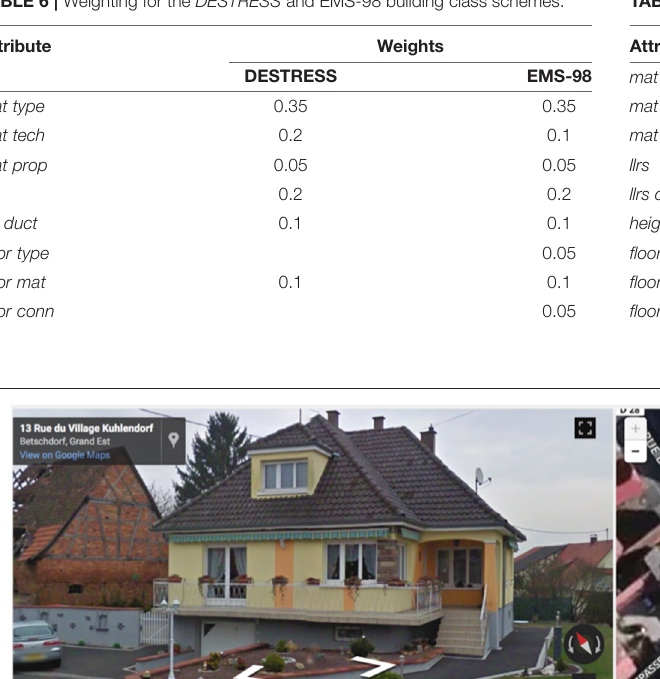
TABLE 6 | Weighting for the DESTRESS and EMS-98 building class schemes. TABLE 7 | Observed attributes of the surveyed building with id = 21123.